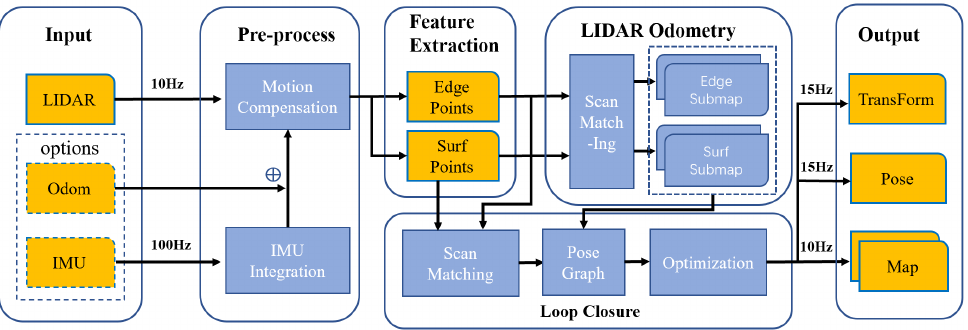
Figure 1. A system overview of the proposed SLAM framework. The main part of this method consists of feature extraction, local lidar odometry and loop closure. Without considering the limitation that the maximum frequency of the input point cloud is 10 Hz, we can achieve a 15 Hz pose estimation and 10 Hz mapping